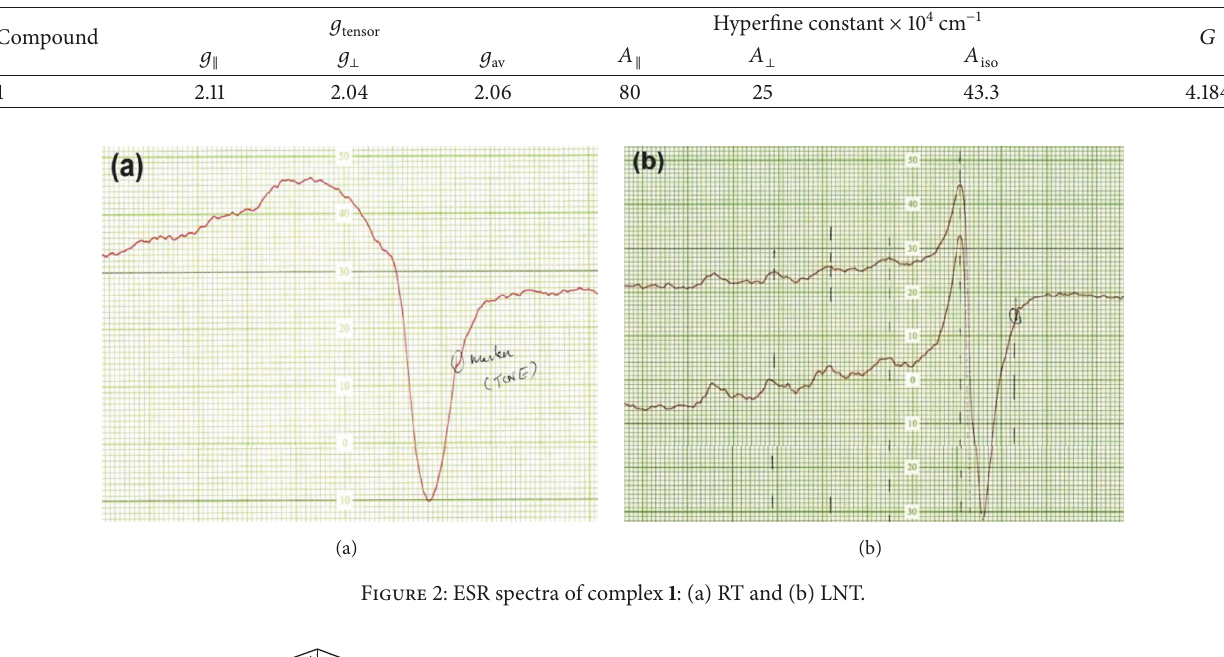
Table 5: The ESR spectral data for complex 1 .